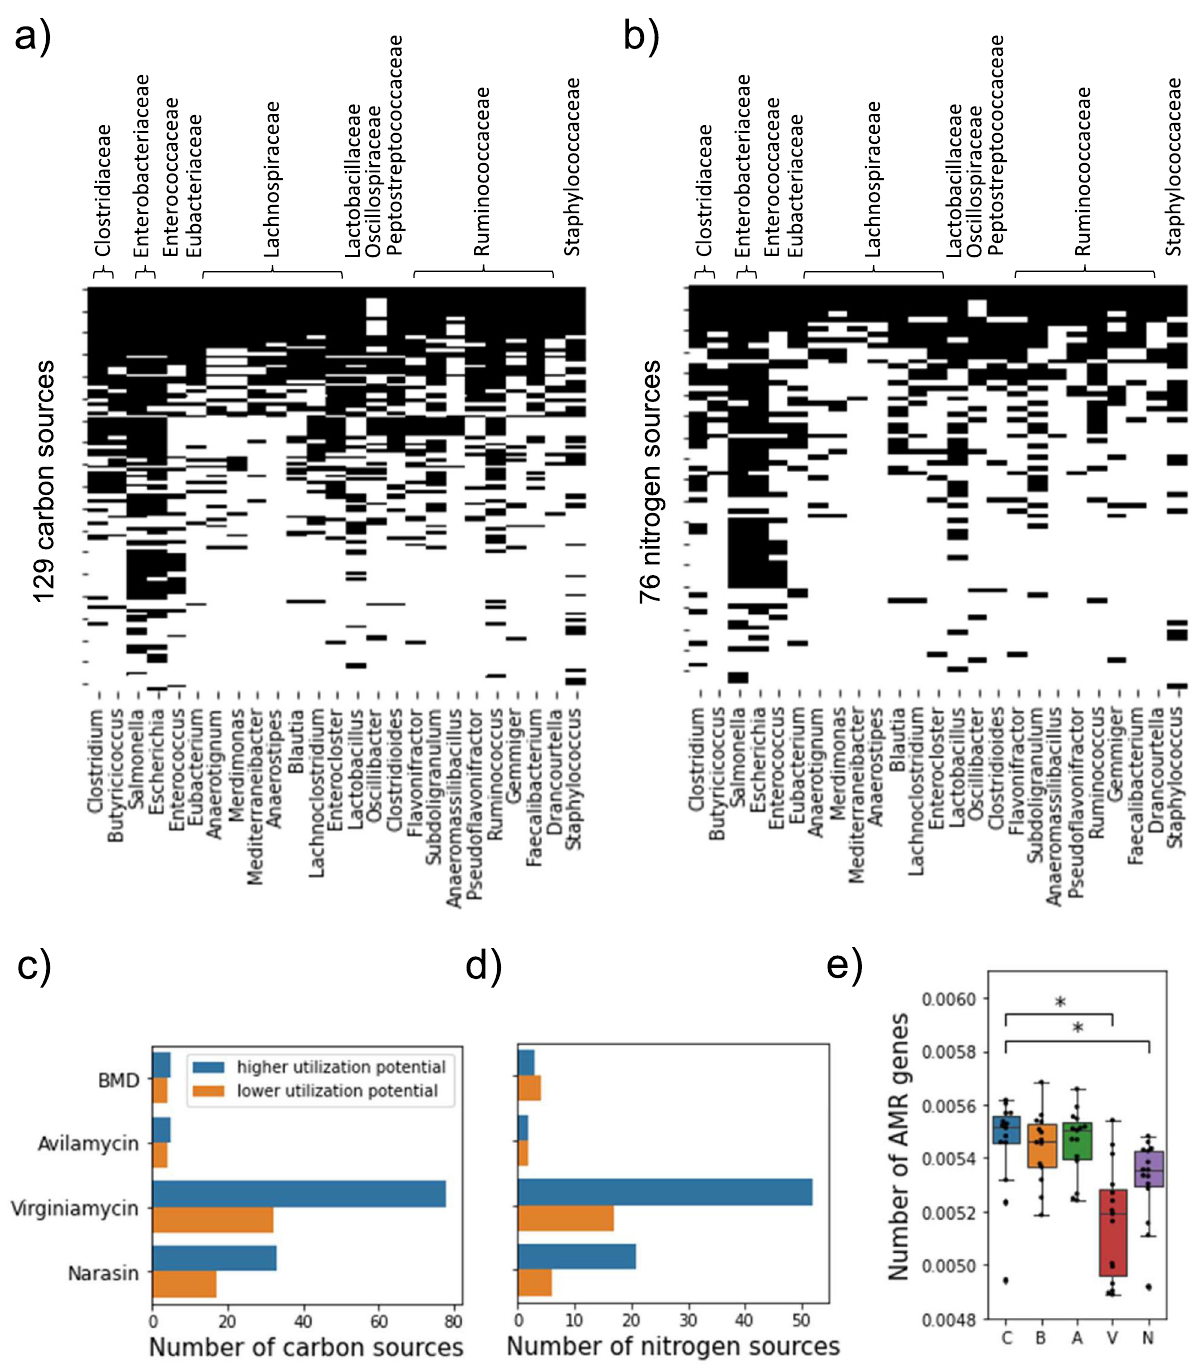
Fig. 5 Predicted metabolic properties of the core cecum microbiome. a ) The predicted ability of each core genera to use individual compounds as main carbon sources for biomass synthesis. Core genera are shown in the columns grouped by taxonomic family. Each row represents a distinct carbon- containing compound. b ) Like a but for the ability to use individual compounds as main nitrogen sources. c ) The number of carbon sources with signi fi cantly (one-sided Mann-Whitney U p-value < 0.05) higher or lower utilization potential in samples from each of the AGP treatments compared to control. d ) Like c but for compounds used as nitrogen sources. e ) The total metabolic demand for core microbiome biomass synthesis across treatments. The total metabolic demand represents the likelihood that any given metabolite is essential for the growth of a random member of the core cecum microbiome. Boxes represent the median and interquartile range; whiskers indicate the range of the distribution excluding outliers. * two-sided Mann- Whitney U p-value < 5 × 10 − 3 . n = 15 birds per treatment. C control, B BMD, A avilamycin, V virginiamycin, N standardized difference between treatments (see Methods). In the (FDR < 0.15). Metabolites related to hemoglobin and porphyrin cecum, dipeptides (Supplementary Fig. 6a) and metabolites metabolism, fructose and galactose metabolism, tocopherol, ino- implicated in amino acid metabolism were signi fi cantly depleted sitol, ribo fl avin and nicotinate and nicotinamide metabolism were by the narasin treatment, along with several long-chain fatty acids enriched. In the serum, phospholipids, fatty acids, and